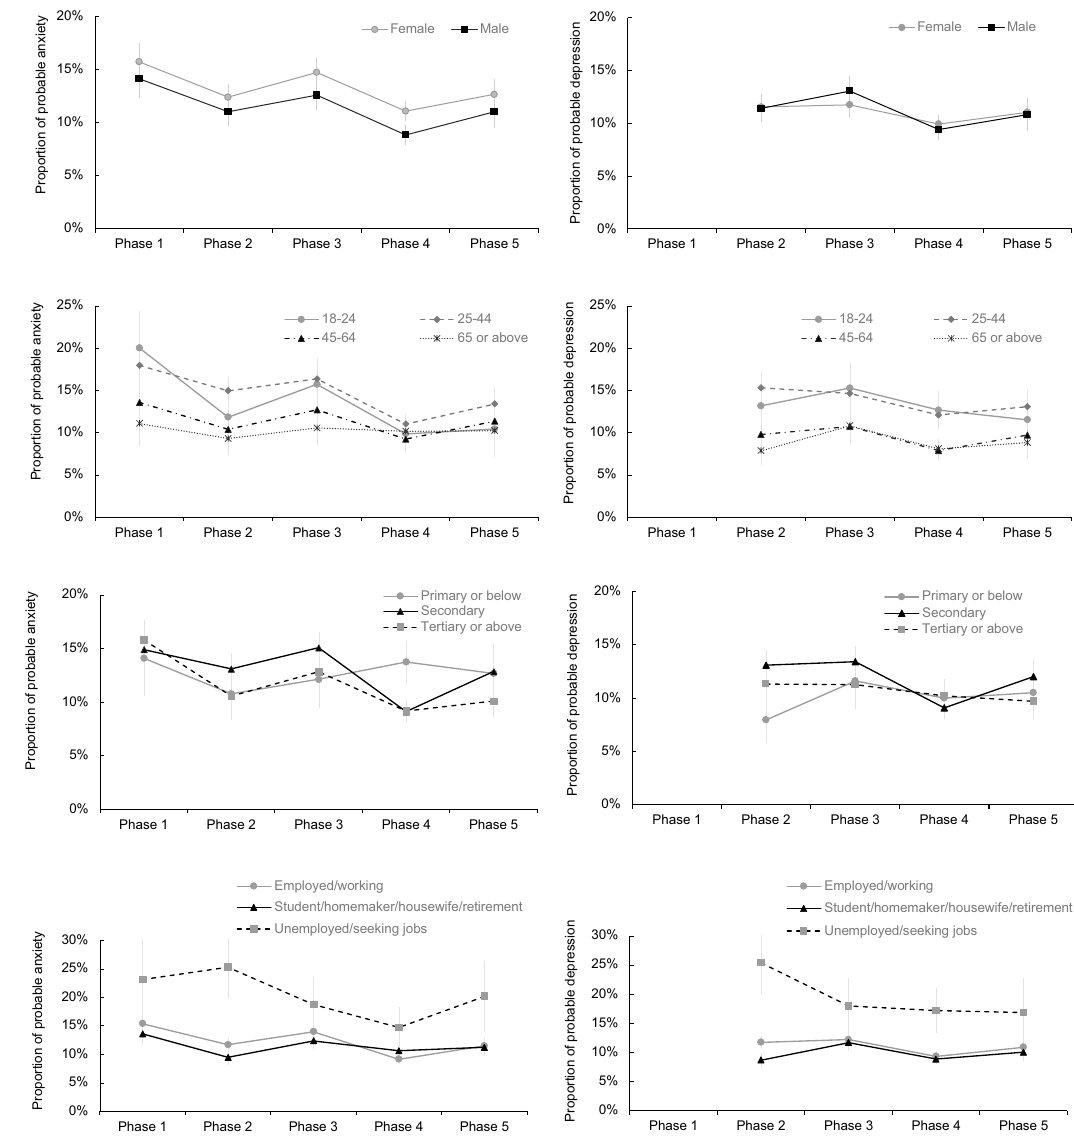
Figure 3. Proportions of respondents who had probable anxiety and probable depression by sex, age, educational attainment and